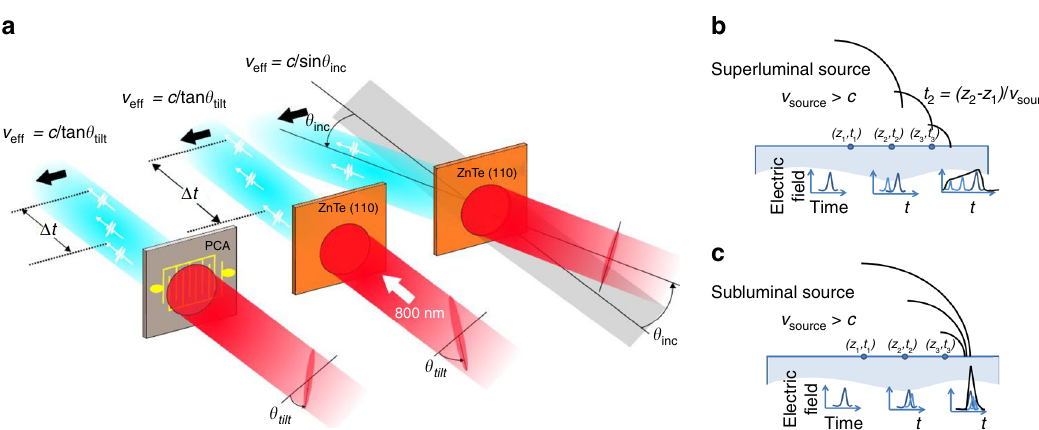
Fig. 1 Effective travelling wave concept, for both a nonlinear material and a photoconductive antenna. a For a tilted pulse front the effective velocity is unbounded, while for an obliquely incident plane wave the effective source velocity is constrained to be greater than c . Tilt and incident angles, θ tilt and θ inc , respectively, are those external to the source material. PCA: photoconductive antenna. b , c Schematic of Huygens waves ( black ) generating the propagating fi eld in the vacuum region above a dielectric medium. The shaded regions represent the dielectric medium. b For a super-luminal source velocity the Huygens waves interfere to give a plane wave, while c for a single-cycle sub-luminal source interference and cancellation is